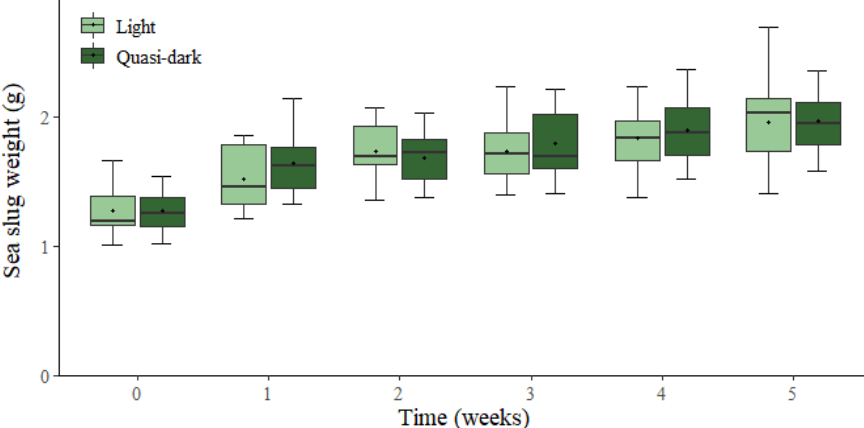
Figure 1. Weight change in the sea slug Elysia crispata reared for five weeks under light (60–90 µ mol photons m − 2 s − 1 ) and quasi dark (5 µ mol photons m − 2 s − 1 ). The sea slugs were fed ad libitum with the macroalga Bryopsis plumosa . The line is the median, the + represents the mean, top and bottom of the box are the 75% and 25% percentiles, respectively, and the whiskers represent the maximum and minimum values ( n = 15).